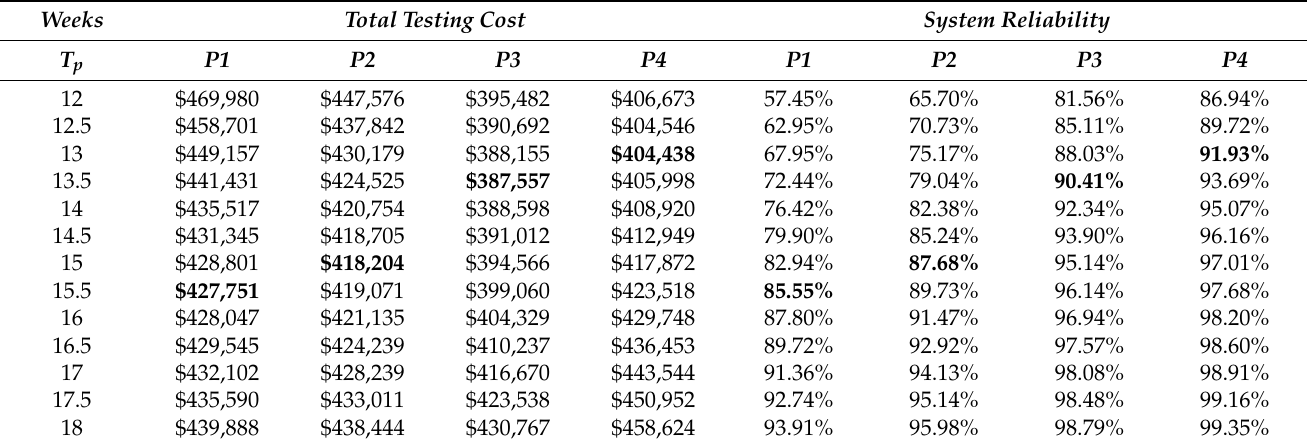
Table 7. The Comparative Results for the Four Alternatives at Different Testing